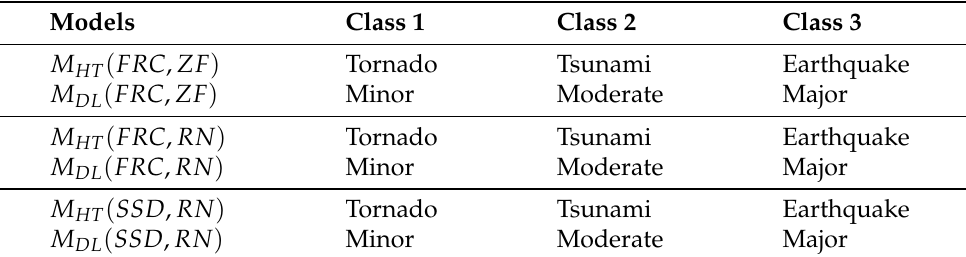
Table 1. Disaster-scene learning models and class